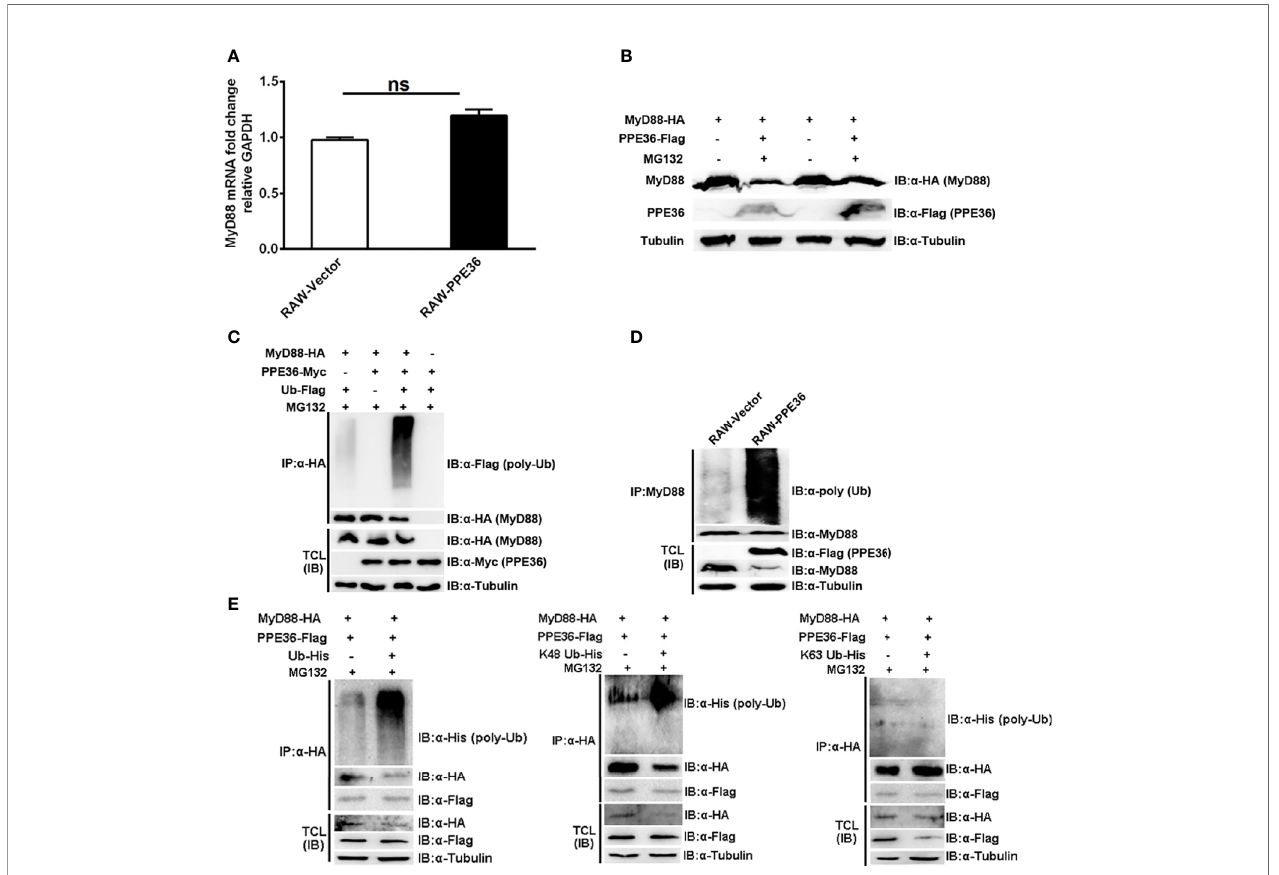
FIGURE 6 | PPE36 promoted MyD88 ubiquitination. (A) MyD88 mRNA expression in PPE36-stably expressing RAW264.7 cells (RAW-PPE36). (B) MyD88 protein expression in HEK293T cells which were co-transfected with pMyD88-HA and pPPE36-Flag in the presence or absence of proteasome inhibitor MG132. (C) Ubiquitination of MyD88 protein in HEK293T cells co-transfected with the indicated combinations of plasmids. (D) Ubiquitination of MyD88 protein in RAW- PPE36 cells. (E) K48-linked and K63-linked ubiquitination of MyD88 protein in HEK293T cells co-transfected with the indicated combinations of plasmids. TCL, total cell lysates; IP, immunoprecipitation; IB, immunoblotting. ns, no signi fi